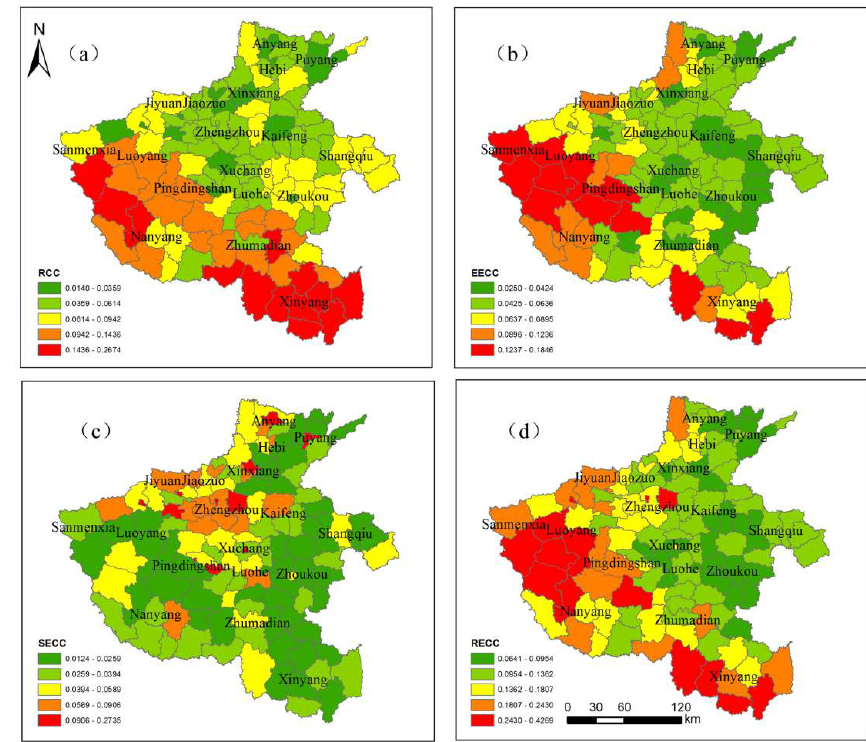
Figure 5. Evaluation results of (a) the RCC, (b) the EECC, (c) the SECC and (d) the RECC in Henan Province.